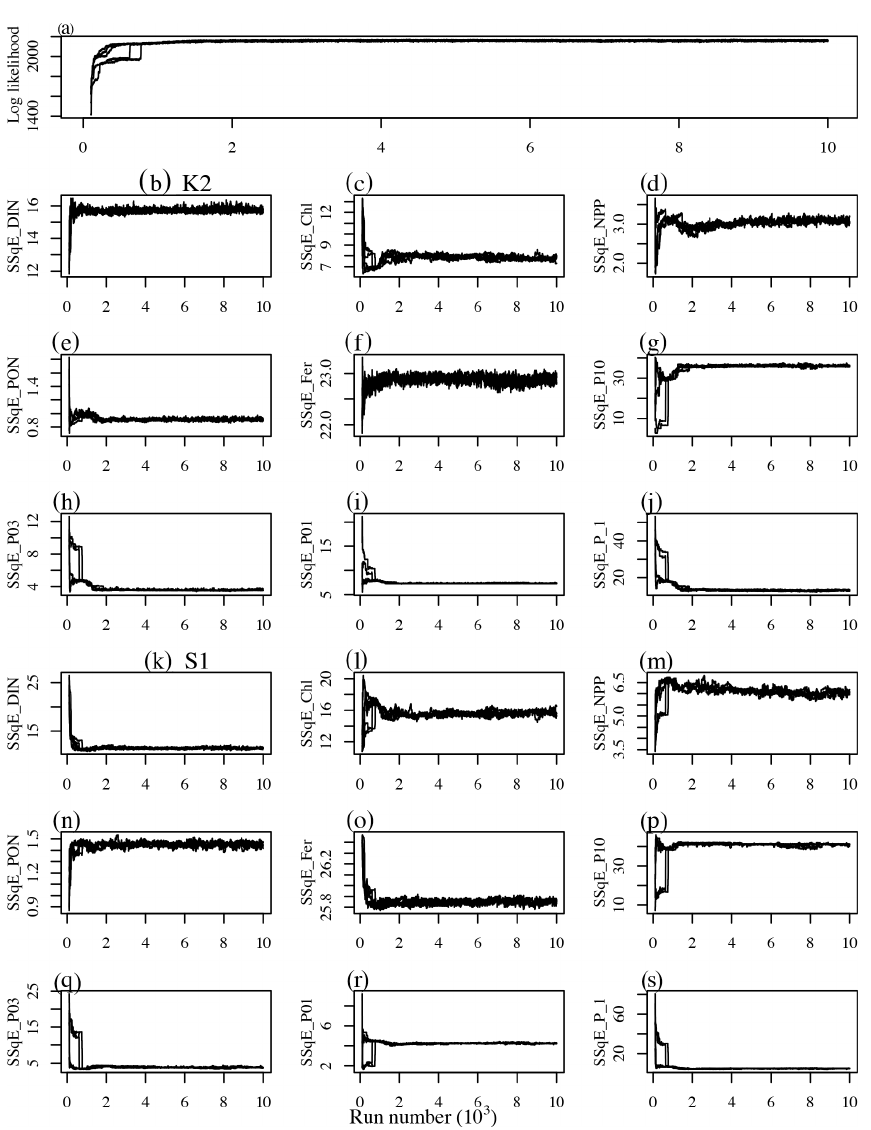
Figure 4. (a) Time evolution of the log likelihood of the MHMC chain. (b)–(j) Time evolution of the sum of squared errors (SSqEs) for DIN, Chl, net primary production (NPP), particulate organic nitrogen (PON), dissolved iron (Fer), and fractions of size-fractionated Chl a concentrations of > 10µm (P10), 3–10µm (P03), 1–3µm (P01), and < 1µm (P_1). (k)–(s) The same as (b)–(j) , but for station